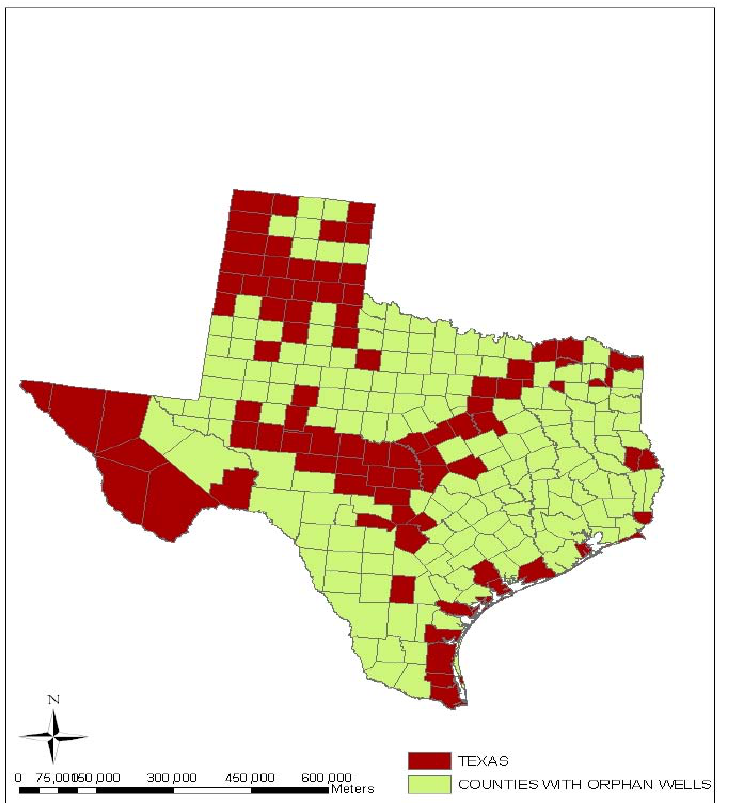
Figure 11 . Spatial Distributions of Orphan Wells in Texas